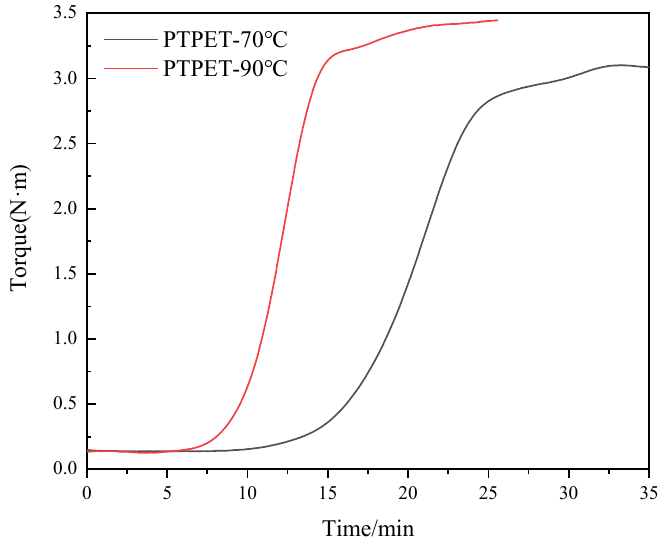
Figure 3. Torque versus time of the reaction between ATPET and GAP inside the twin-screw ex- truder.